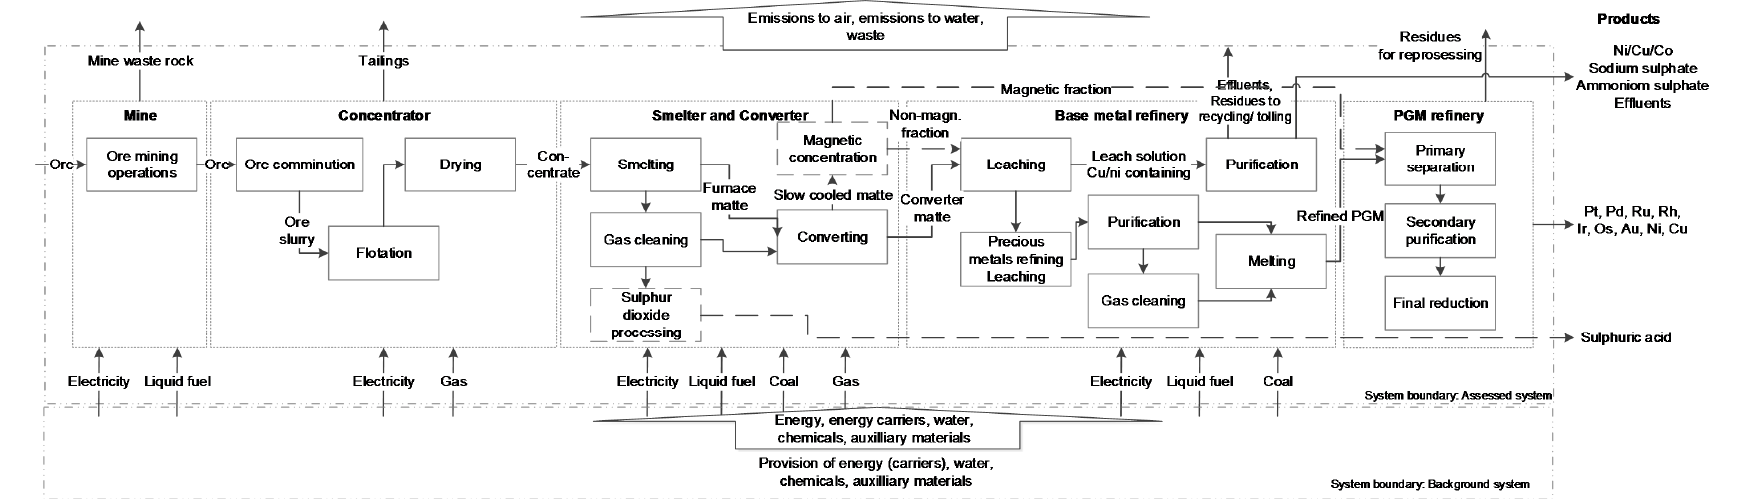
Figure 2. Production steps of PGE production.